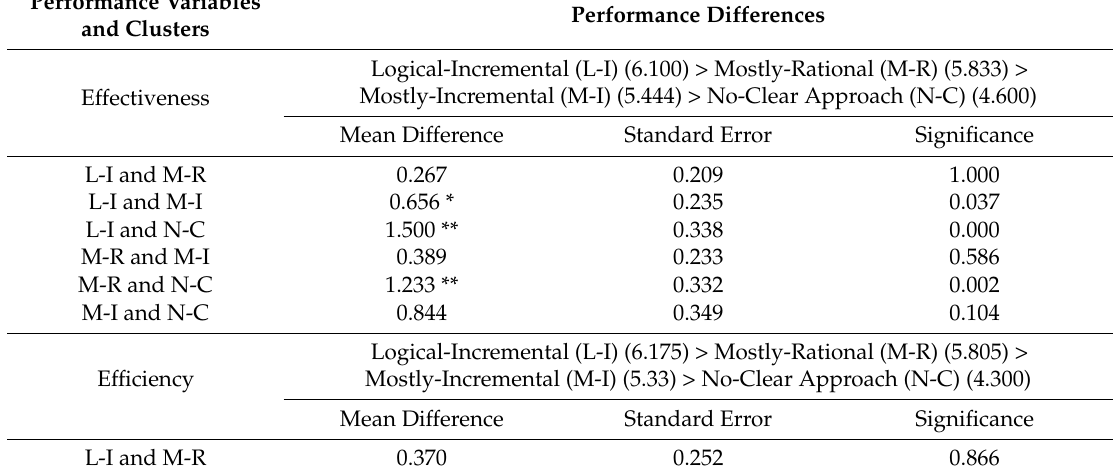
Table 3. Perceived performance across strategy implementation style